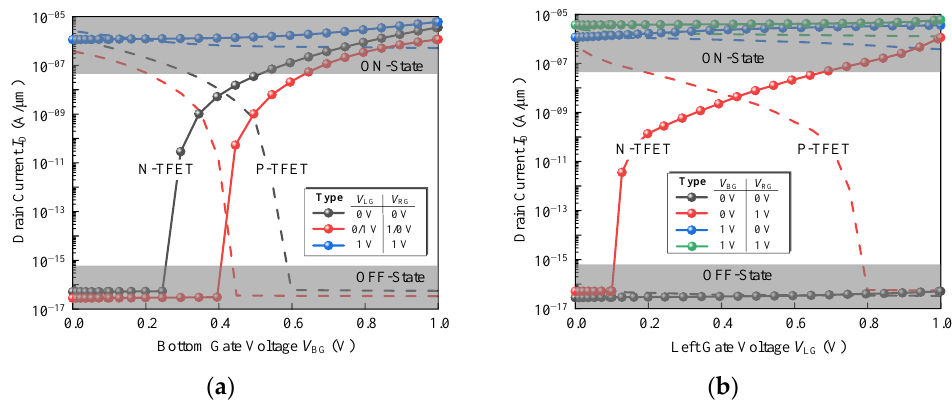
Figure 12. ( a ) I D - V BG and ( b ) I D - V LG curve of the proposed device exhibiting AndOr behavior. The dotted lines are for N-type device and dashed lines for P-type.